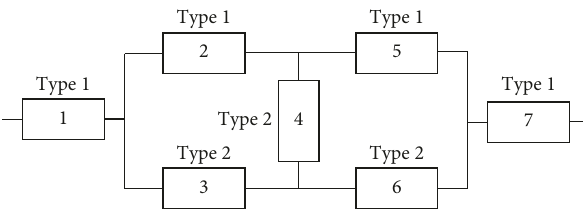
Figure 3: Bridge system with 7 components of 2 types. Table 3: All possible swapping cases for type 1 component.